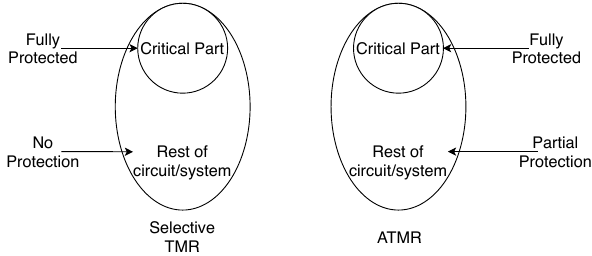
Figure 1. Selective Hardening: Selective TMR &